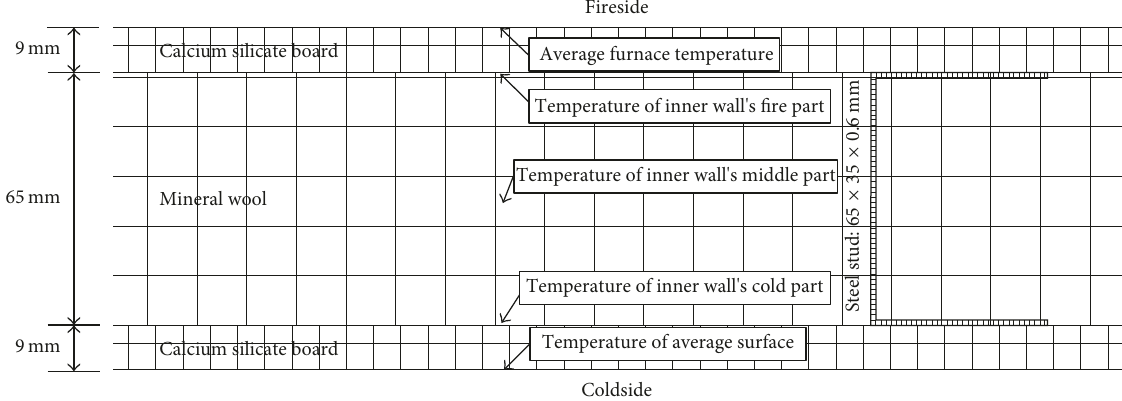
Figure 3: Cross section of the wall with indication of numerical modelling and the thermocouple position in Test 1.